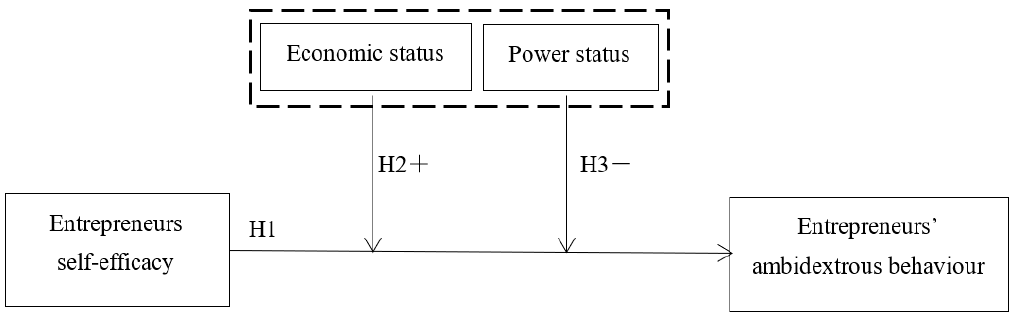
Figure 1. Theoretical